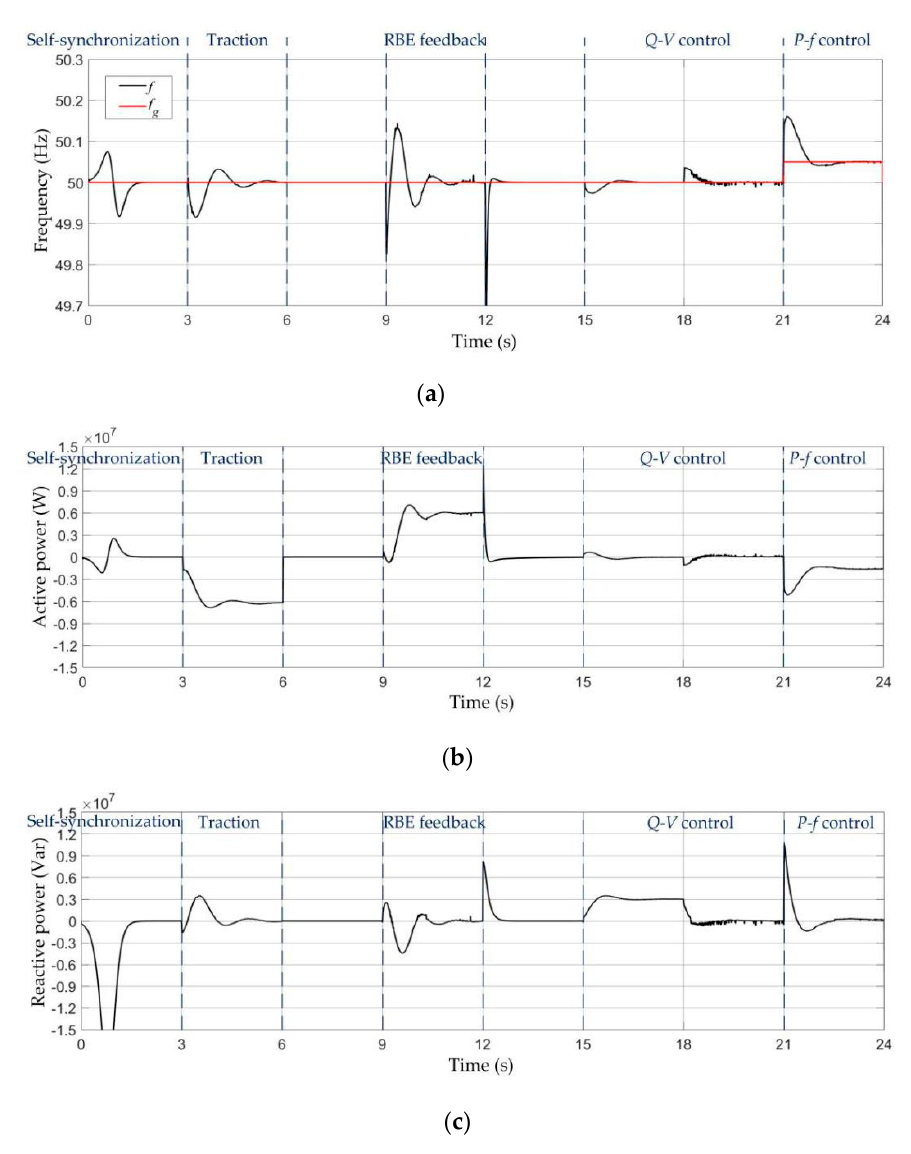
Figure 16. The system outputs under grid normal condition: ( a ) the grid frequency f g and the system output frequency f ; ( b ) the system output active power P ; and ( c ) the system output reactive power Q .